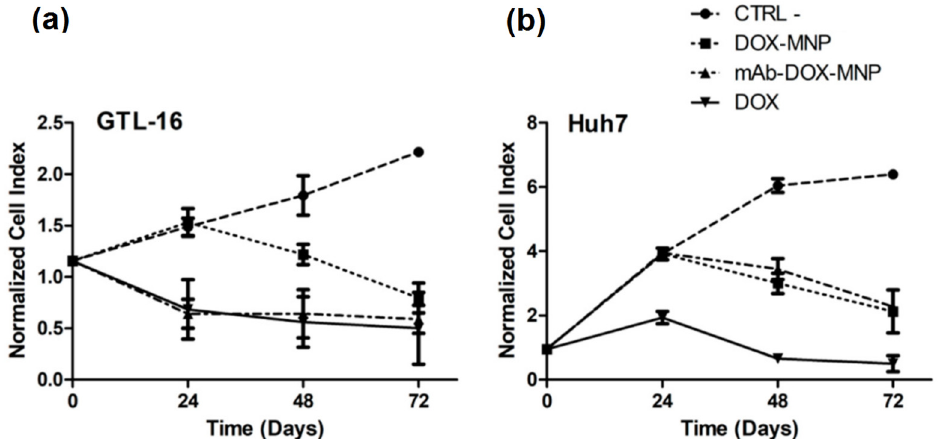
Figure 14. Cytotoxicity of mAb-DOX-functionalized nanoparticles against ( a ) Met/HGFR-positive GTL-16 and ( b ) Met/HGFR-negative Huh7 cells. Adapted from reference [41]. GTL-16 and ( b ) Met/HGFR-negative Huh7 cells. Adapted from reference